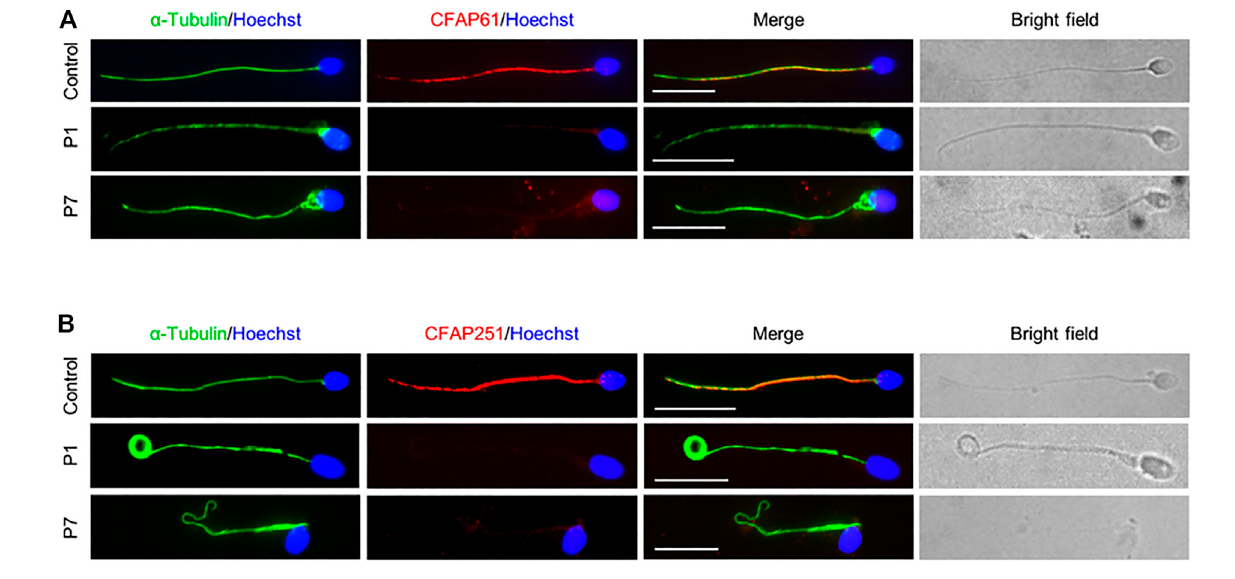
Frontiers in Cell and Developmental Biology |